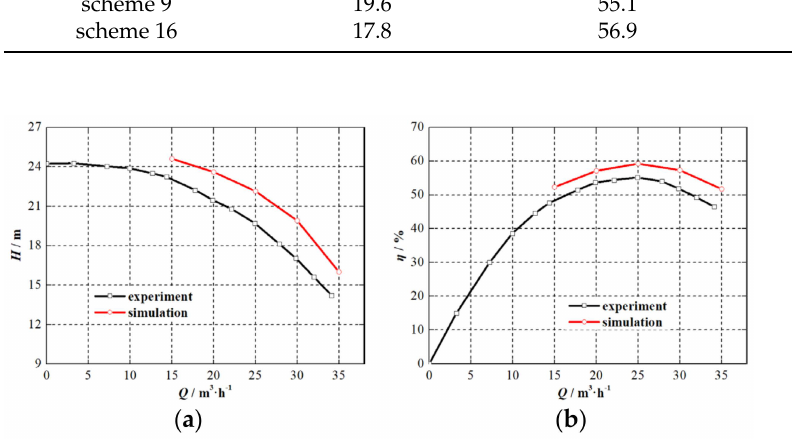
Figure 17. Scheme 9 pump performance. ( a ) H - Q curve. ( b ) η - Q